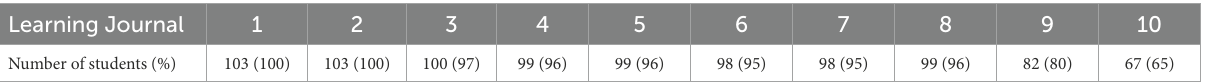
TABLE 1 Overview of learning journal entries